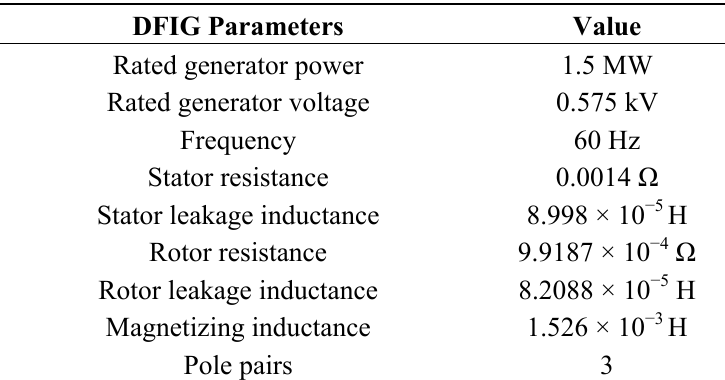
Table 1. DFIG system